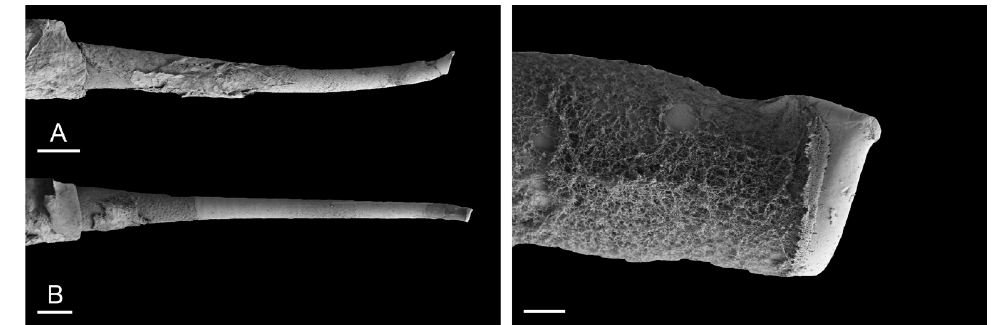
Fig. 37. Paromoionchis boholensis gen. et sp. nov., unit #1, spine of accessory penial gland. A . Holotype, Philippines, Bohol [3288] (PNM 041266). B . Philippines, Bohol [3372] (PNM 041269). C . Distal tip of spine, same as B. Scales: A–B = 100 μm; C = 10 μm.